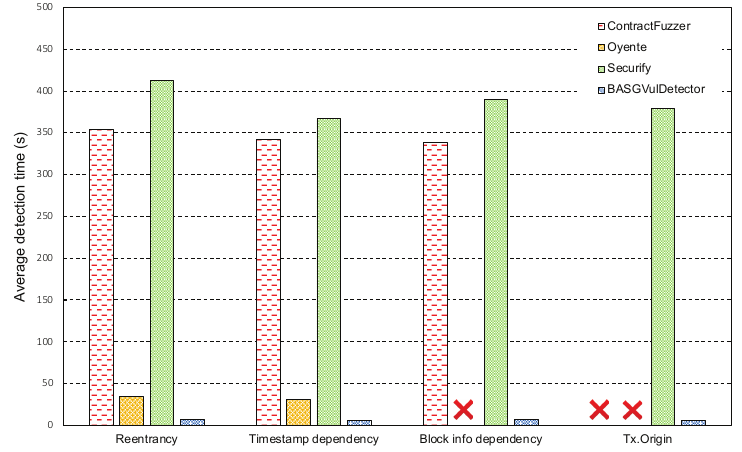
Figure 7. Comparison of detection time for BASGVulDetector